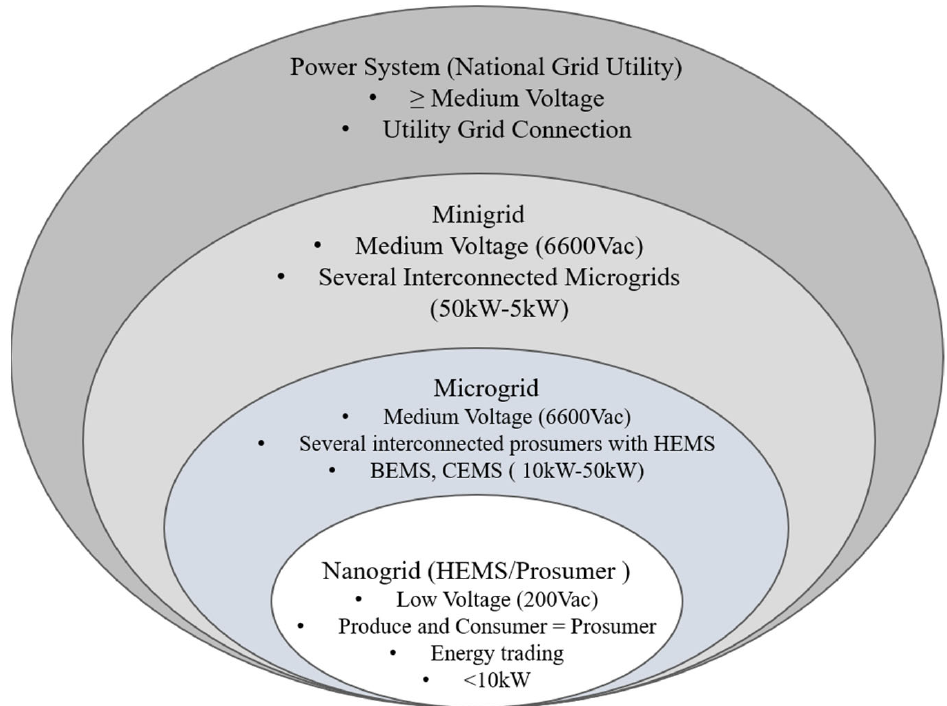
Figure 1. Classification of grids by capacity.